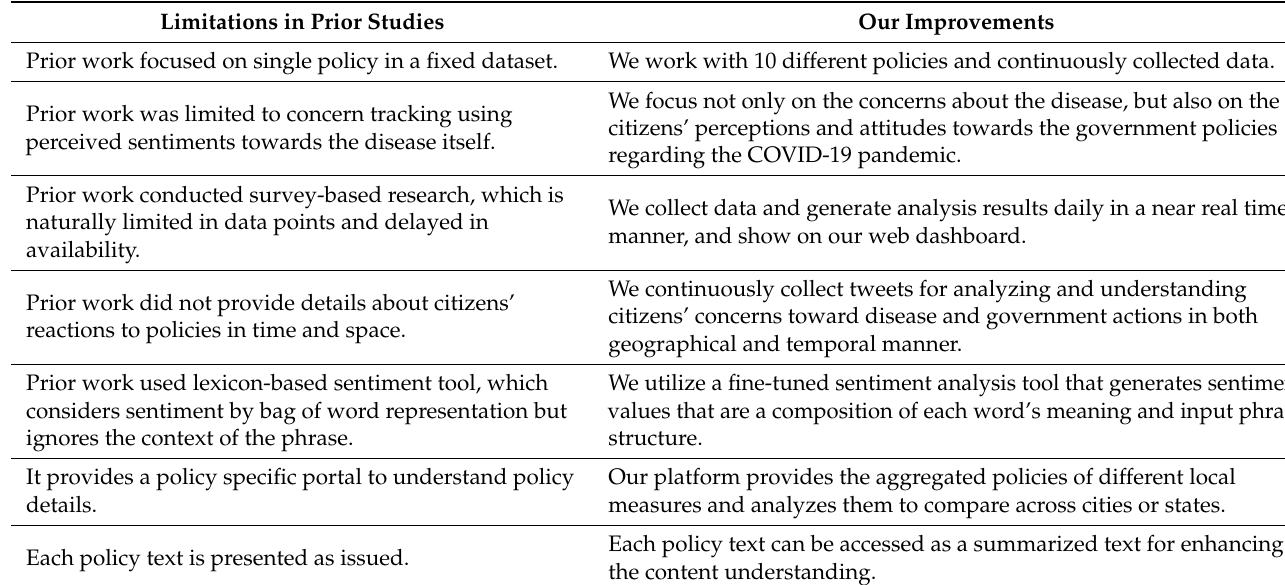
Table 8. Our improvements to prior